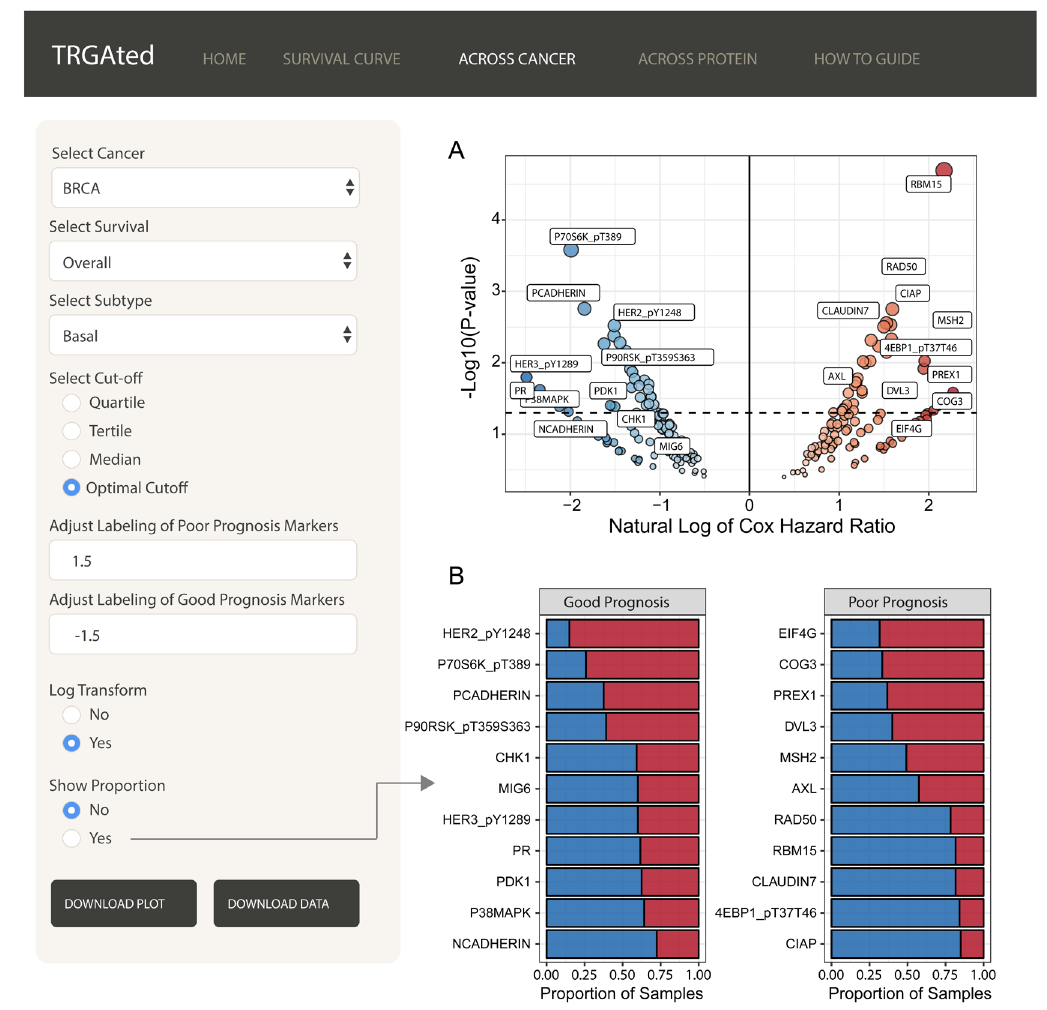
Figure 3. Visualizing all proteins across a single cancer type. The interface shows an example of the visualization of Cox hazard ratio of each protein across the basal subtype of breast cancer ( A ). Good prognostic markers appear on the left in blue, while poor prognostic markers are on the right in red. The natural log transformation allows the graph to be centered at 0 and makes the visualization of good prognostic markers easier. Labeling for proteins can be adjusted to include more or less protein. Proportional comparisons for protein using the optimal cutpoint function is available as well ( B